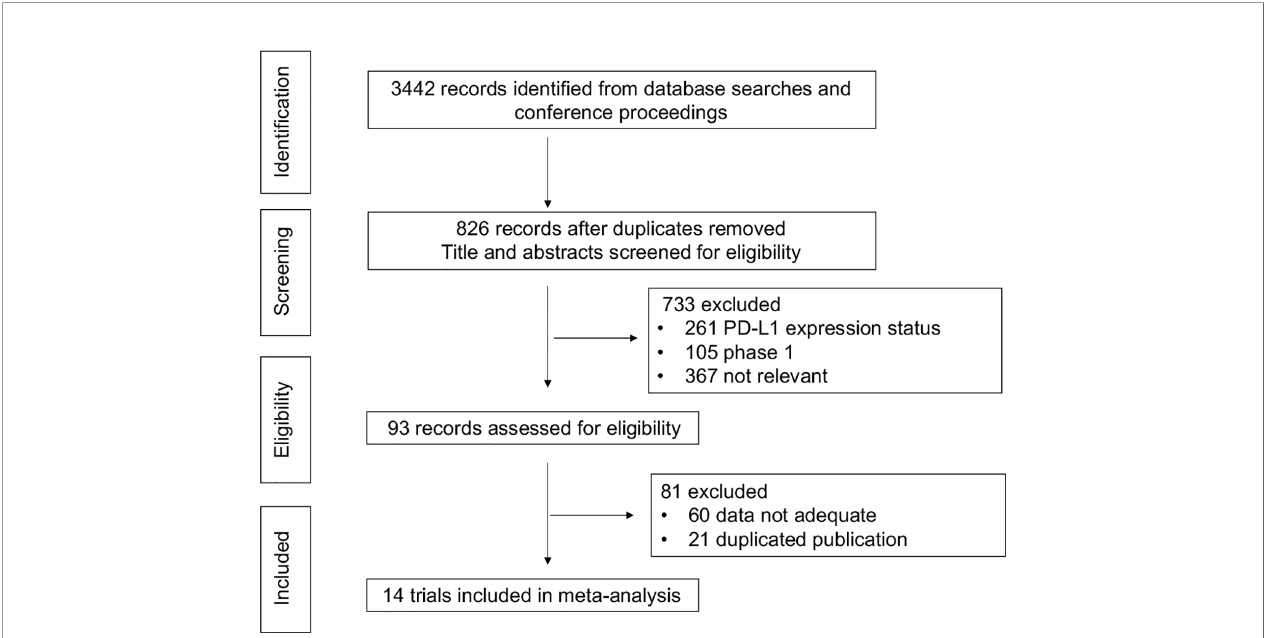
FIGURE 1 | Selection process for the trials included in the meta-analysis. PRISMA diagram. NSCLC, non-small cell lung cancer; RCT, randomized-controlled